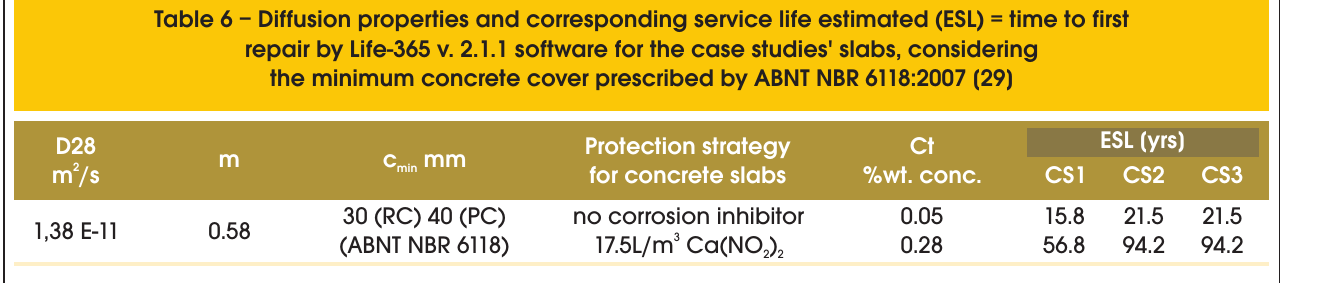
Table 6 – Diffusion properties and corresponding service life estimated (ESL) = time to